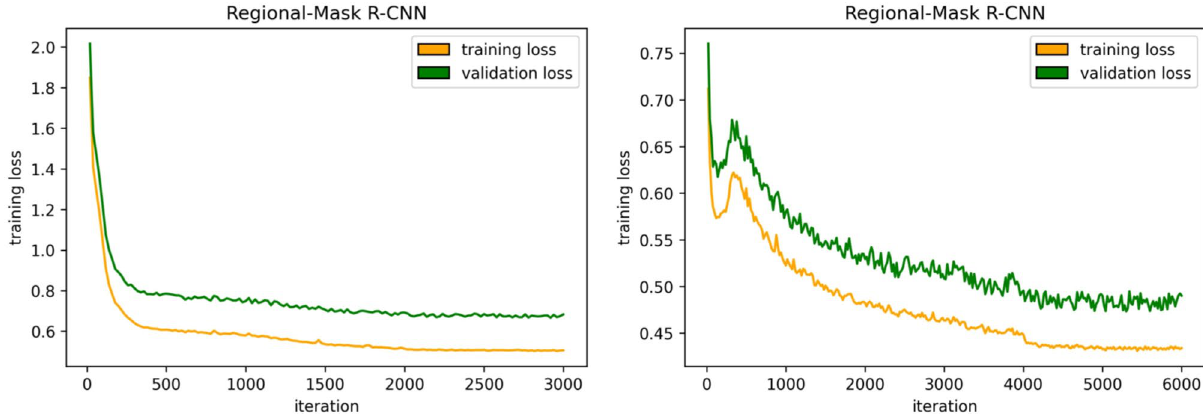
Figure 3. Training and validation losses convergence plots, the left-hand-side plot is an example of the WSI Mask R-CNN model training, and the right-hand-side one is an instance of the training of the Regional Mask R-CNN